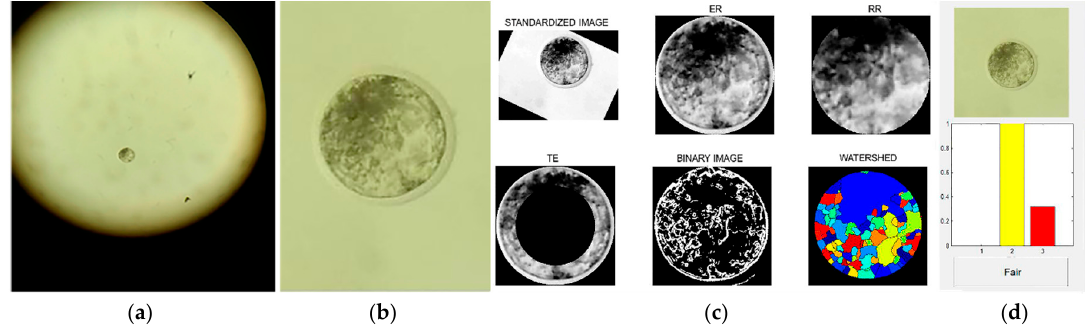
Figure 6. ( a ) Original image from the smartphone (Dataset 2). ( b ) Image expanded by resizing (scaling algorithm software). ( c ) Blastocyst segmentation by Blasto3Q. ( d ) Final output (blastocyst classification as “fair”) of Blasto3Q.